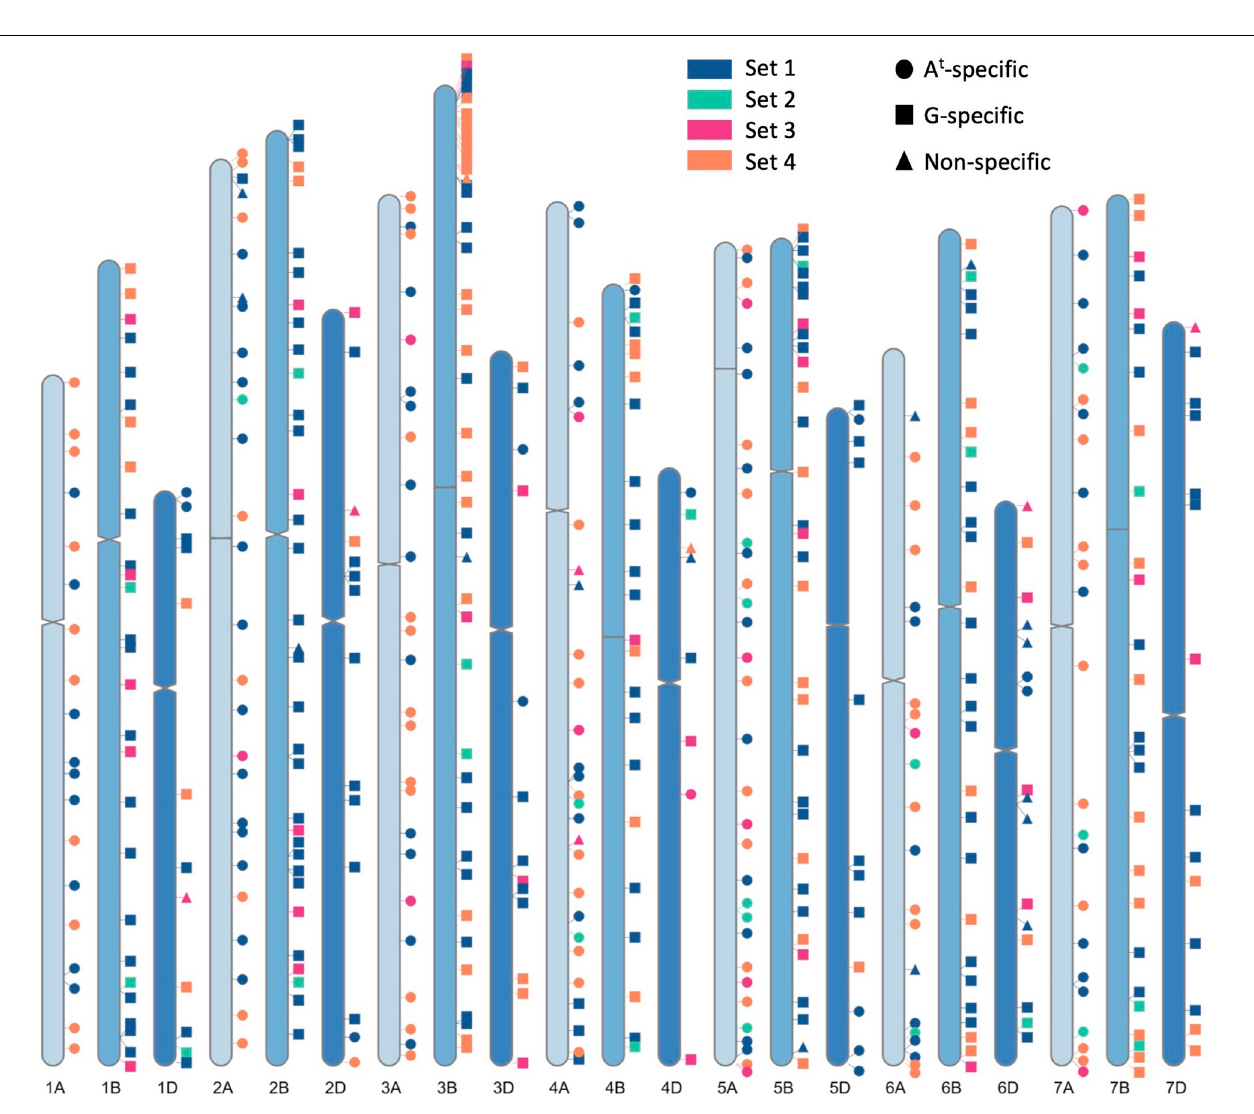
Fluor TM 594-5-dUTP (Invitrogen; C11400; coloured red).